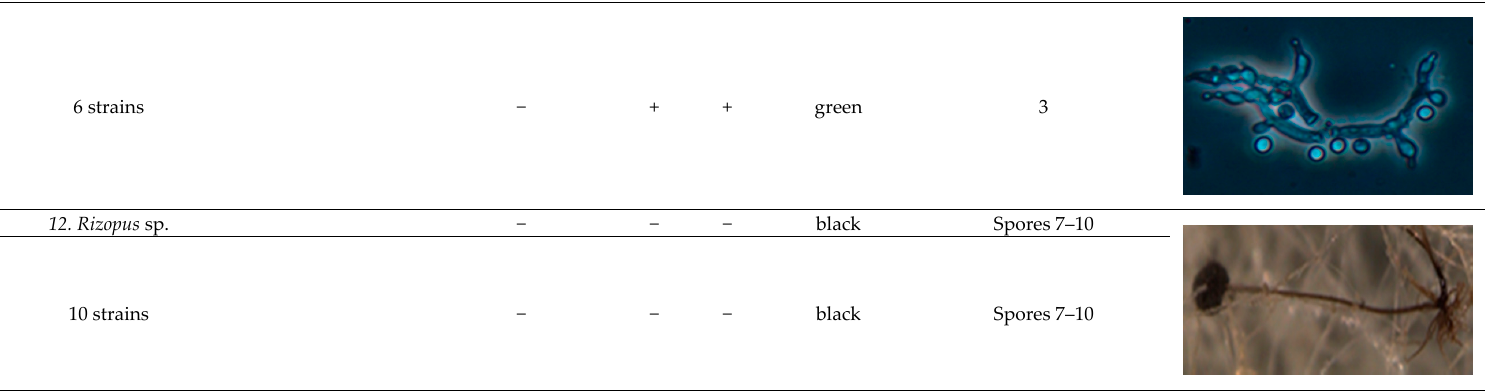
Table 7. Cont. Int. J. Environ. Res. Public Health 2018 , 15 ,